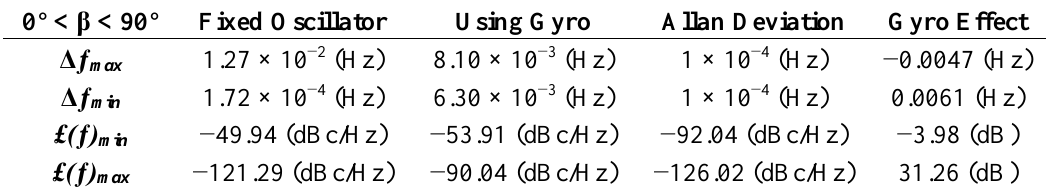
Table 7. Analysis of gyroscopic mounting efficiency for crystal with |φ| =